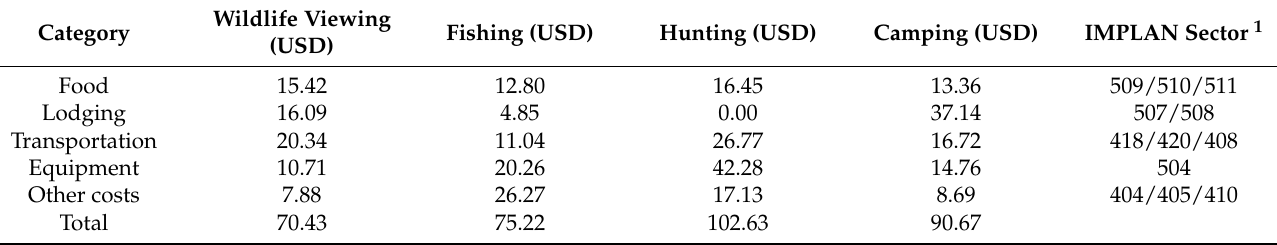
Table 10. Per-person-per-day visitor expenditures in Florida by category per activity type with corresponding IMPLAN sector. Category